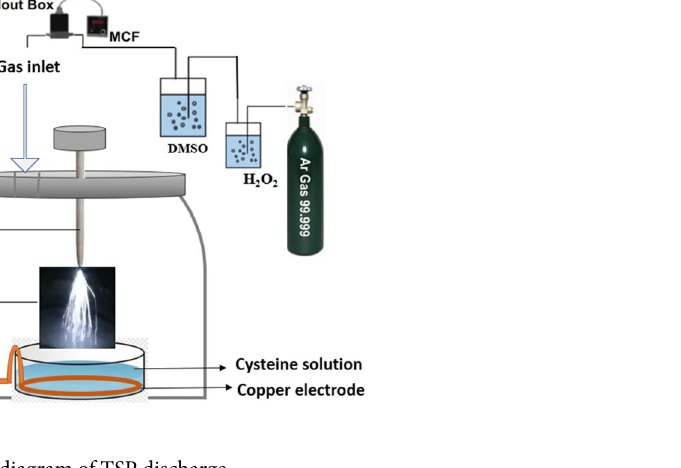
Figure 1. A schematic diagram of TSP